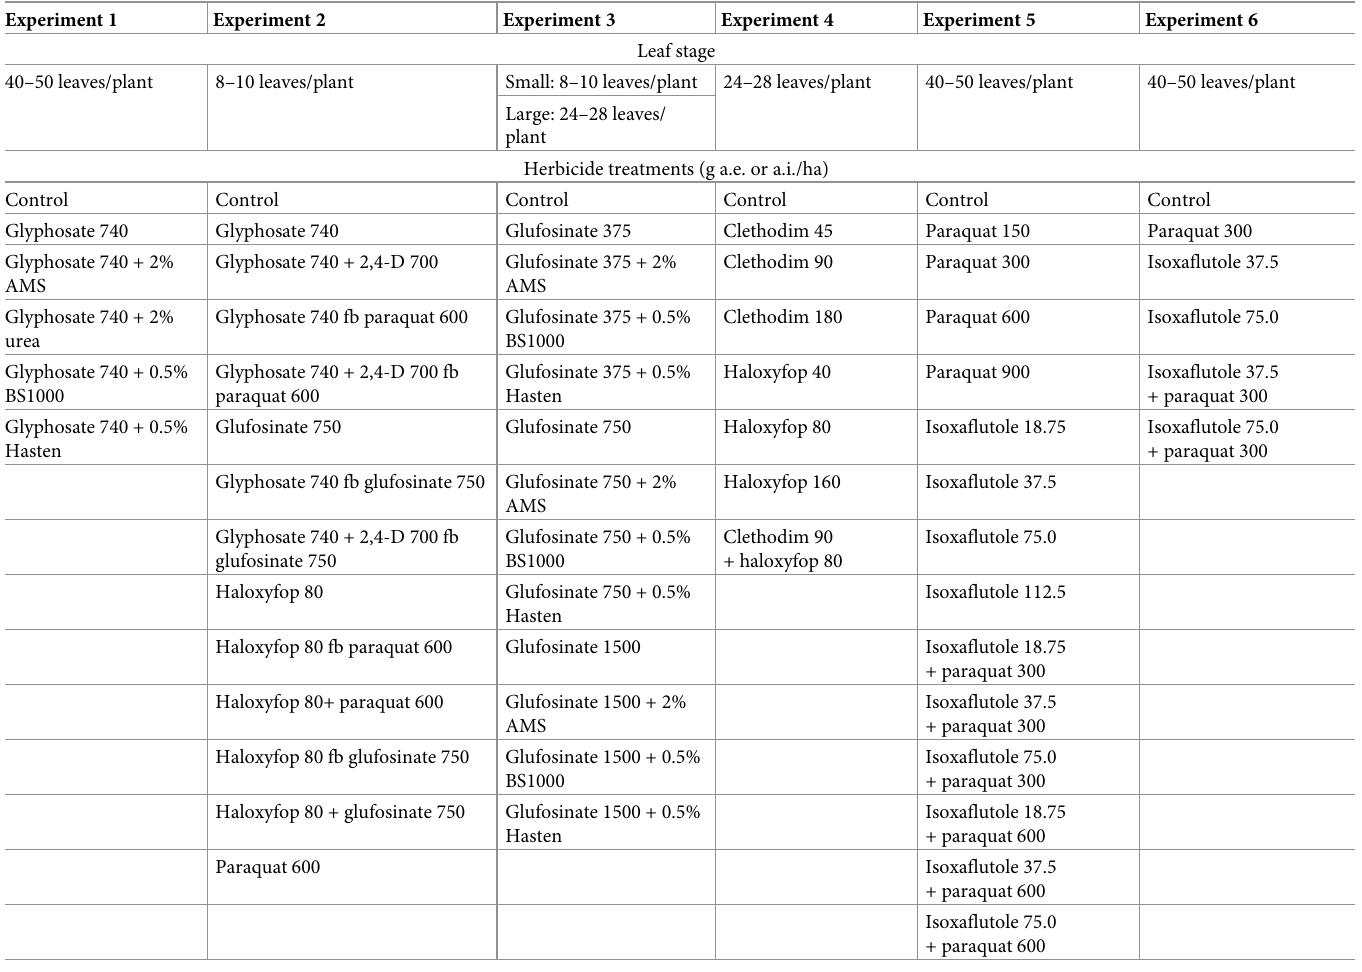
Table 1. Leaf stage and herbicide treatments included in different